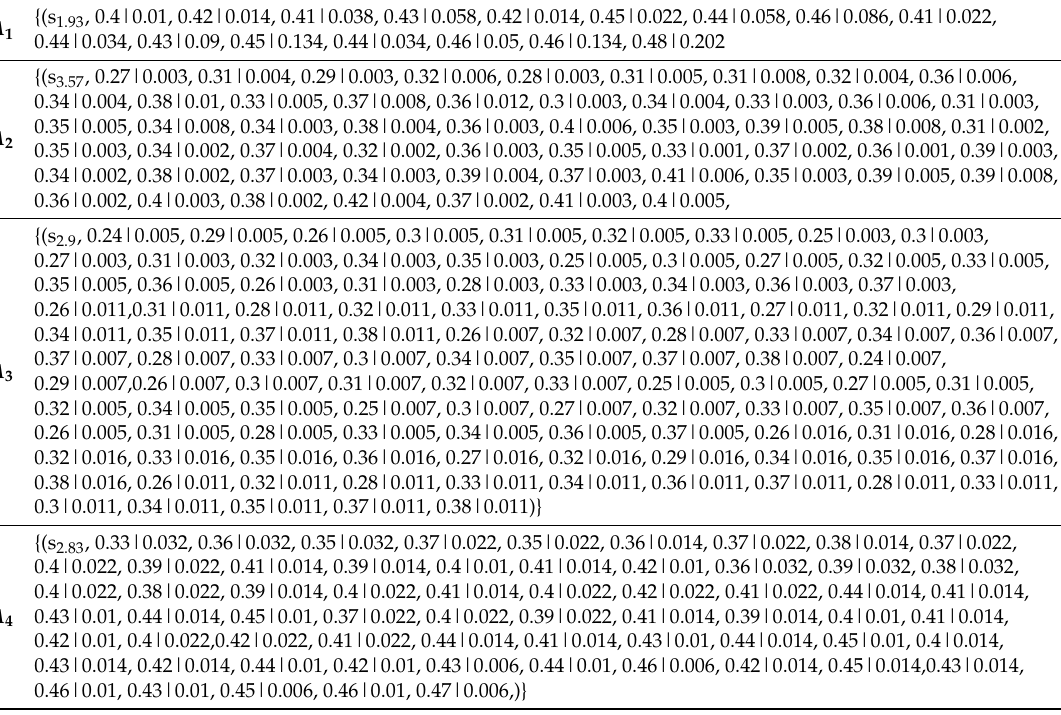
Table 7. Collective HPFLE group decision matrix using HPFLWG operator.